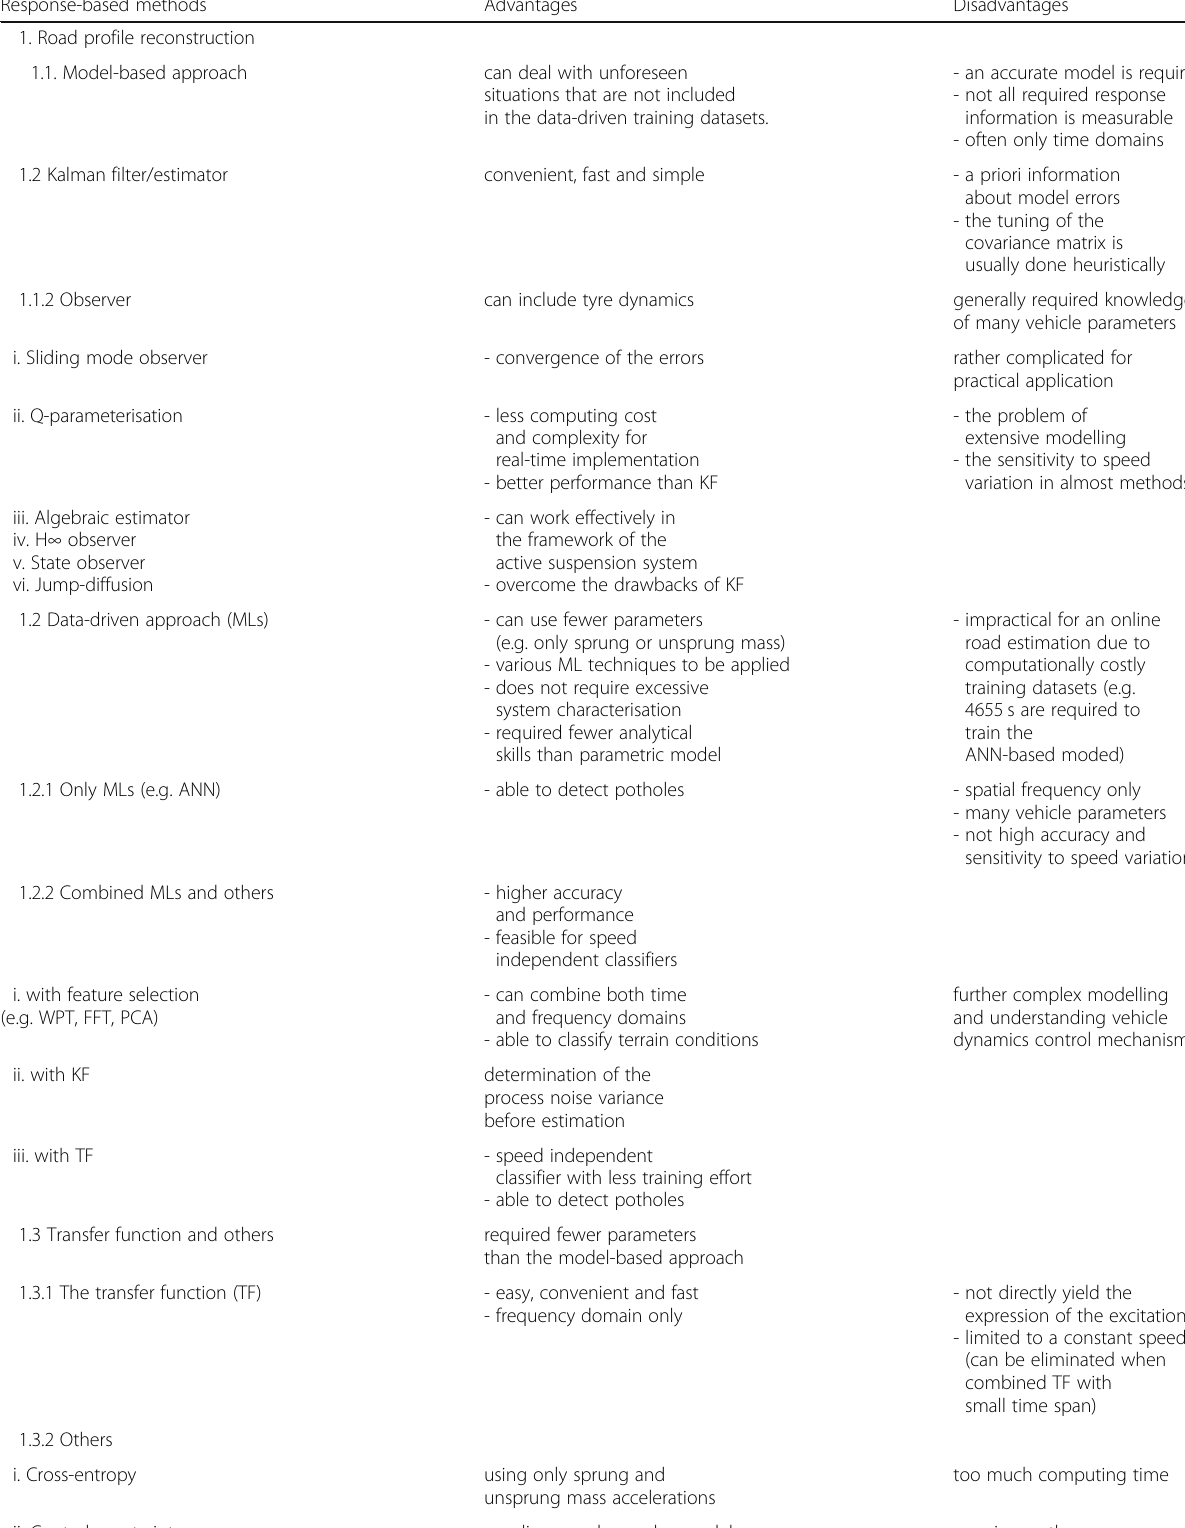
Table 7 Advantages and disadvantages of response-based